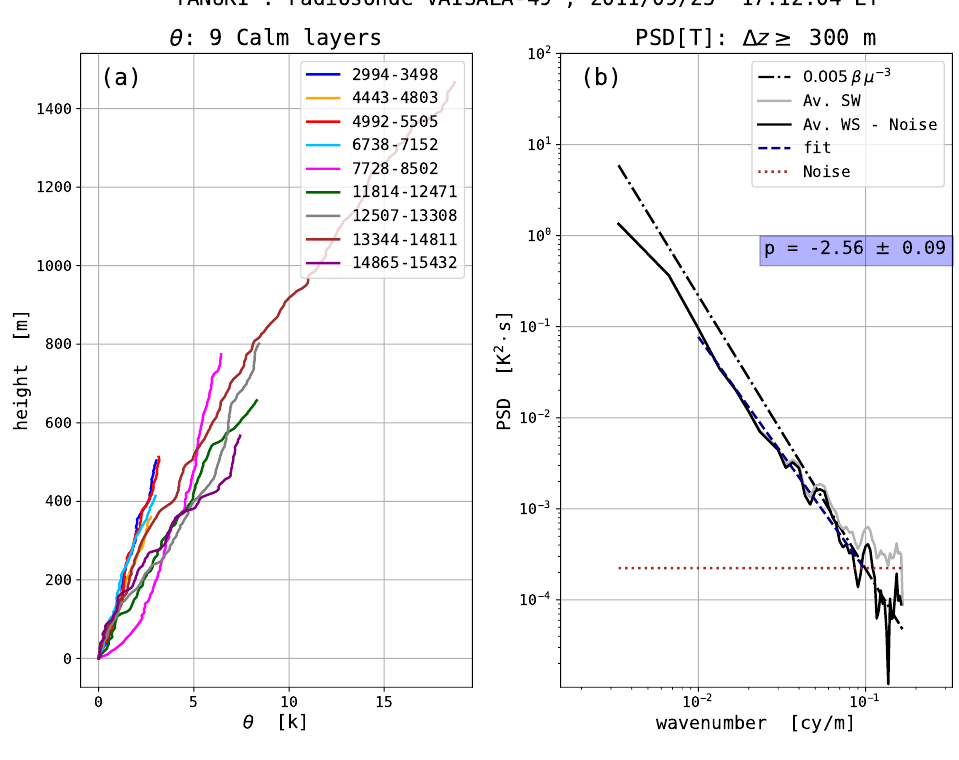
Figure 8. Same as Figure 7 but for the nine stable layers of flight